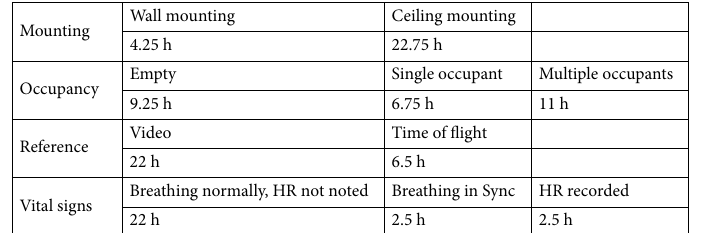
Board (protocol ID#2023). All research was performed in accordance with the protocol and with relevant guide- lines and regulations, and all test subjects gave informed consent.